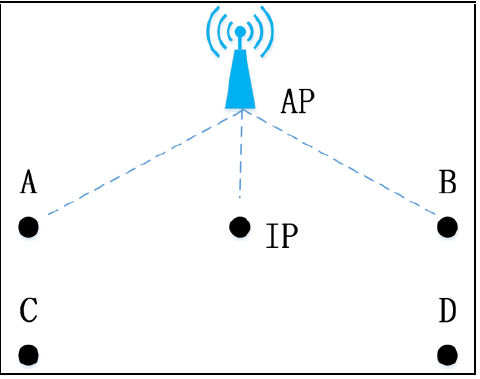
Figure 1. The unsuitable situation for the existing interpolation methods in RSS estimation.